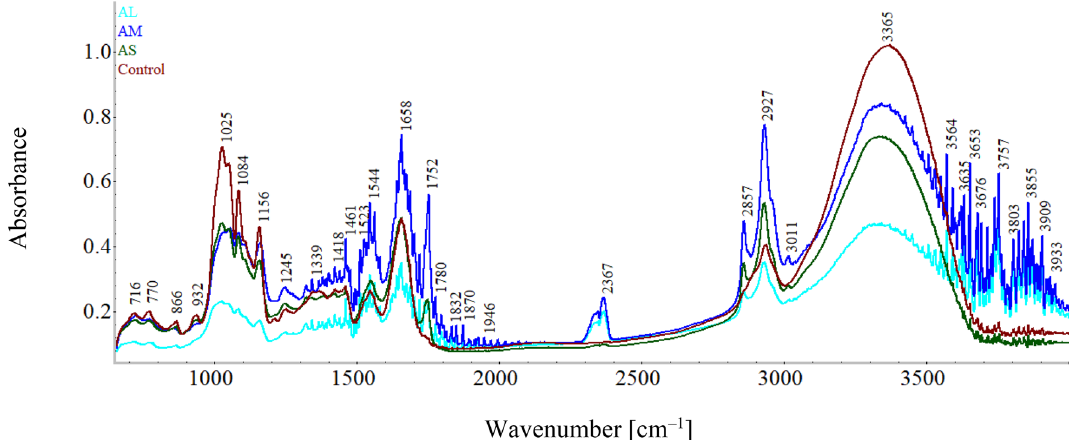
Figure 2. FT-IR spectra of wheat flour and amaranth flour particle sizes, large (AL), medium (AM) and small